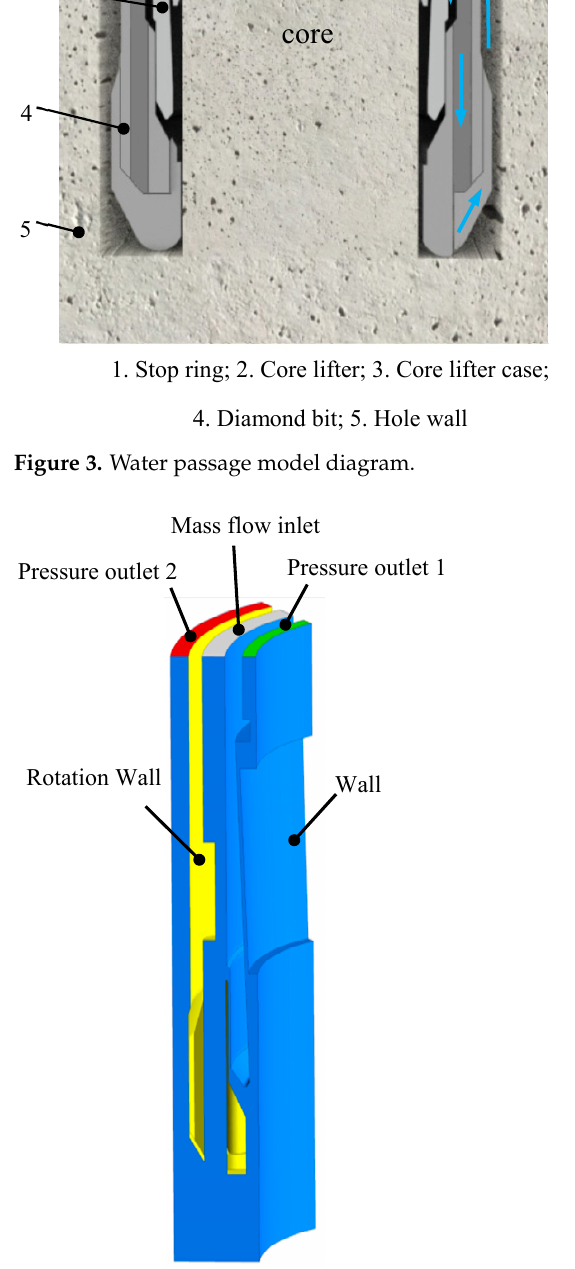
Figure 4. Water passage simulation model and boundary diagram.